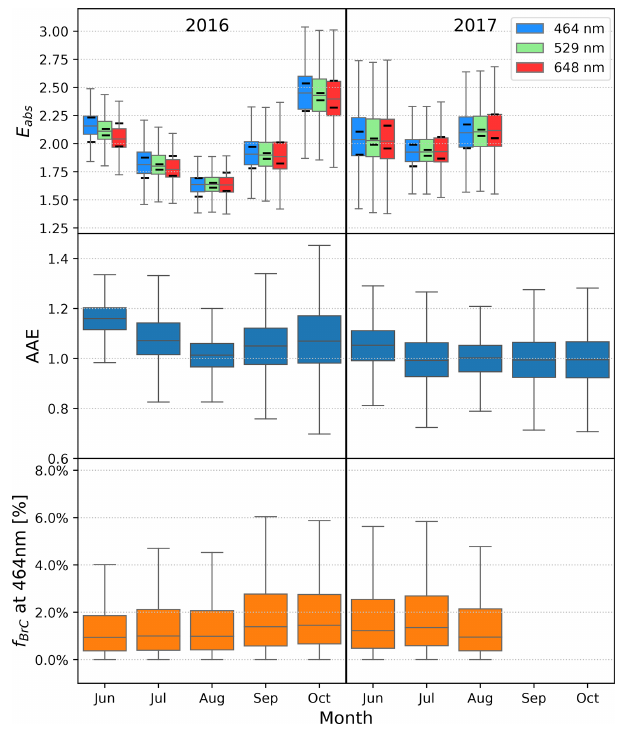
Figure 2. Monthly percentiles (10%, 25%, 50%, 75%, and 90%) of absorption enhancement E abs , AAE (between 464 and 648nm), and calculated BrC contribution to total absorption at 464nm as box–whisker plots spanning the fire season in 2016 and 2017. E abs is calculated by assuming an AAE of 1 for the fresh BC. The solid black lines in the upper panel indicate the upper and lower boundary of the calculated median E abs when the AAE is in the range of 0.8–